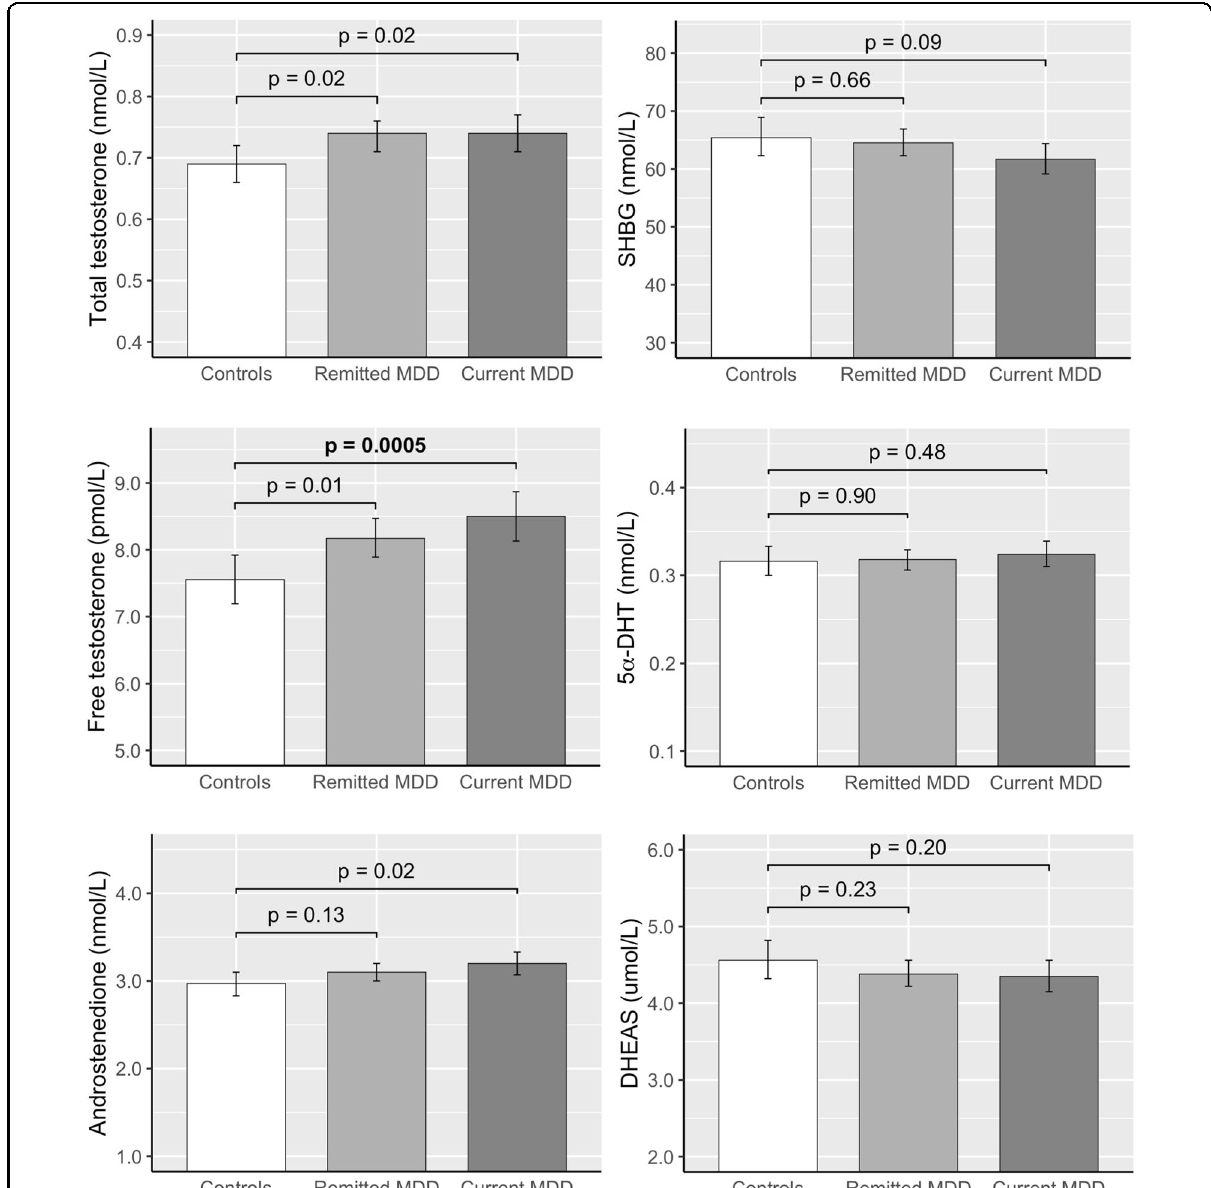
Fig. 1 Mean androgen and SHBG levels in women according to their diagnosis at baseline. Abbreviations: 5a-DHT, 5 α -dihydrotestosterone; DHEAS, dehydroepiandrosterone-sulfate. Data are geometric means with 95% CI. p -values are based on adjusted mean analyses by ANCOVA models. Models were adjusted for age, education, BMI, smoking, alcohol use, number of treated chronic diseases, menopausal status, oral contraceptive use, and hormonal replacement therapy